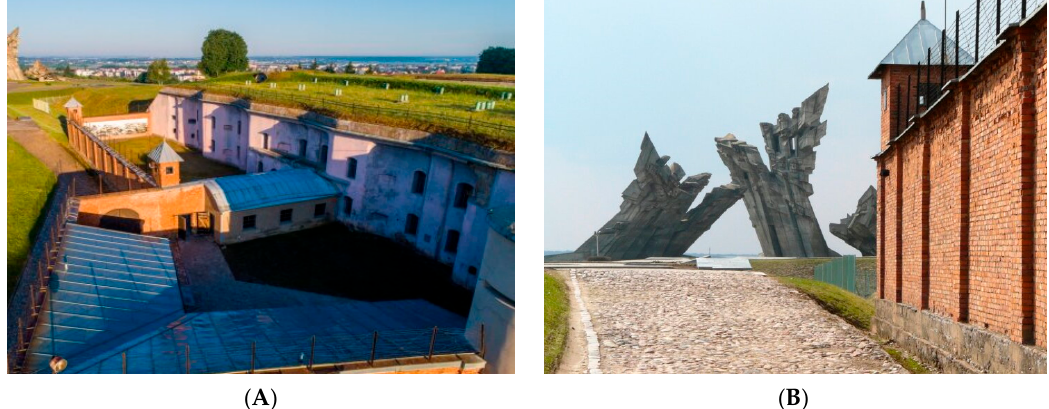
Figure 11. ( A ) The Building of former 9th Fort in Kaunas, Lithuania. Available online: https://tinyurl.com/2p969snd; https://tinyurl.com/4j4hcb6j (accessed on 23 March 2022); ( B ) The Building of former 9th Fort in Kaunas, Lithuania. Available online: https://tinyurl.com/2p969snd; https://tinyurl.com/4j4hcb6j (accessed on 23 March 2022).